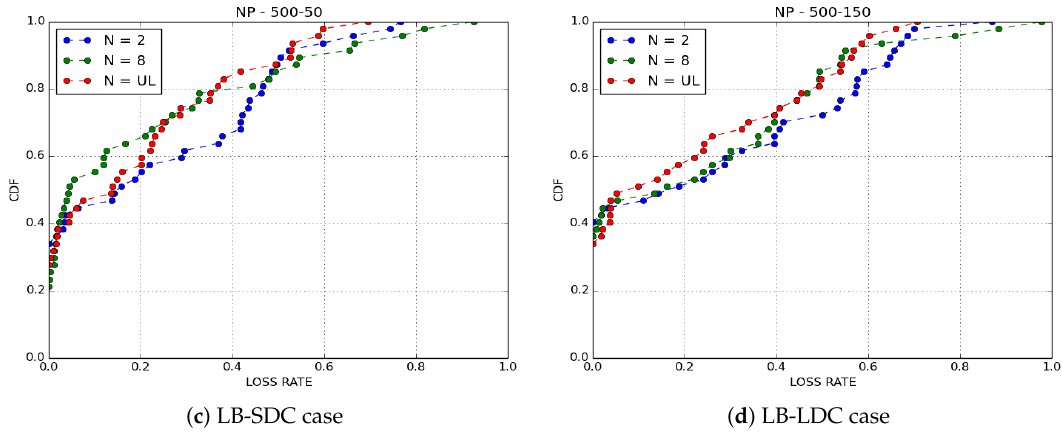
Figure 10. Loss rate for NP buffer management policy.